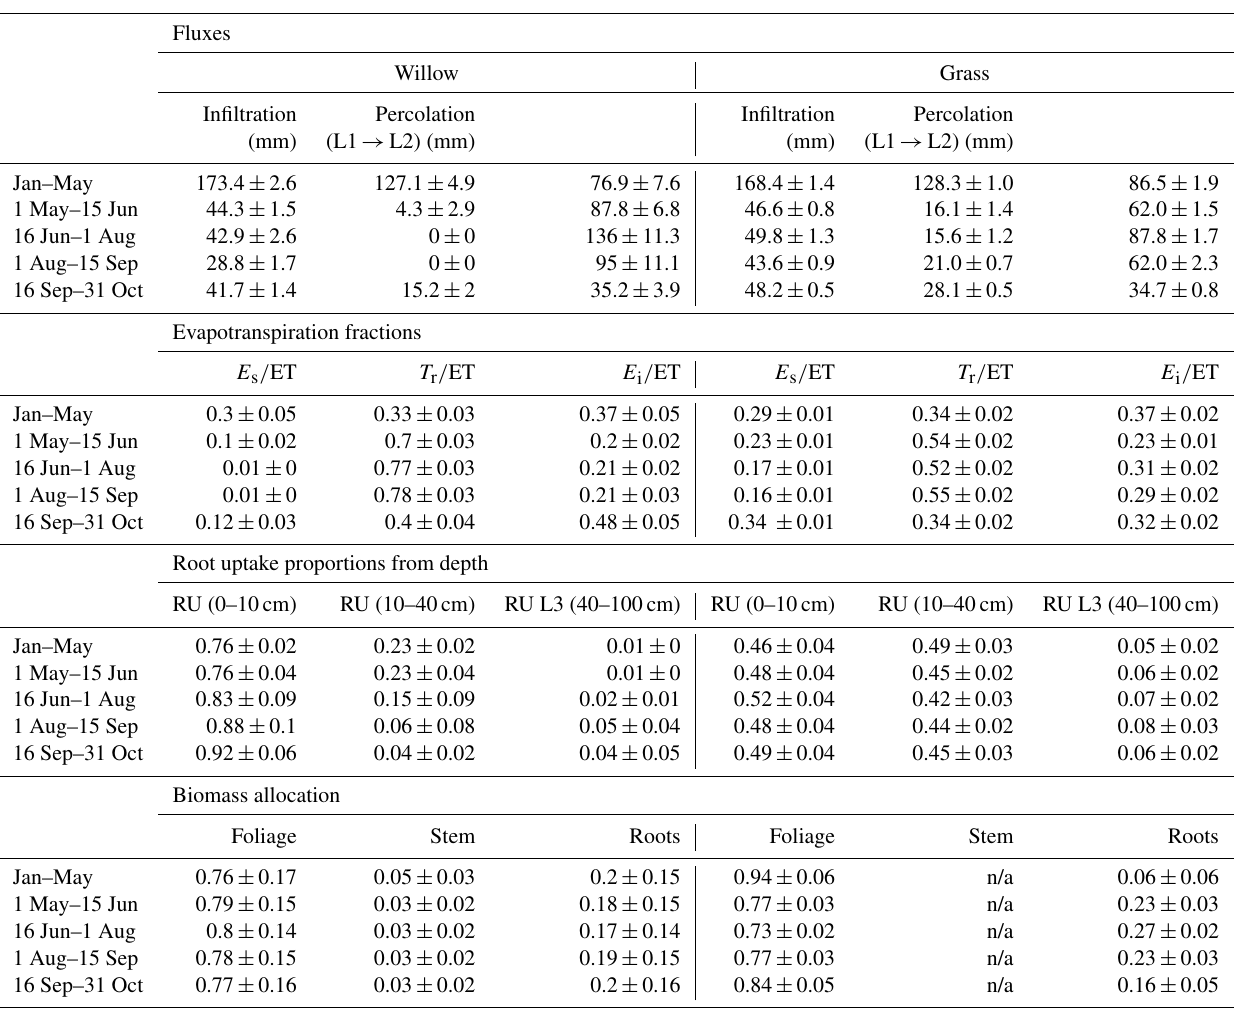
Table 3. Mean (and standard deviation) of water partitioning before (January–May) and during the early growing season (1 May–15 June), mid growing season (16 June–1 August), and late growing season (1 August–31 October). Also shown are the root uptake (RU) proportions from each soil layer (L1, L2, and L3 are layers 1, 2, and 3, respectively) and biomass allocations. Depth of the L1, L2, and L3 are 0–10, 10–40, and 40–100cm, respectively. Note that infiltration and percolation are cell averages; ET is specific to vegetation (proportion of willow in cell < 100%). ET is evapotranspiration; E s is soil evaporation; T r is transpiration; and E i is interception